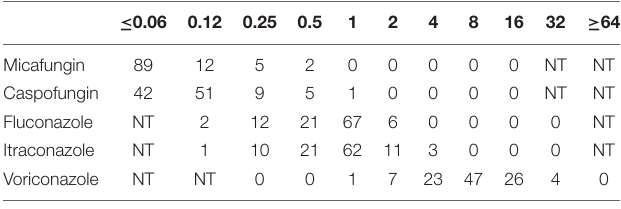
TABLE 1 | The number of strains with MIC50 value of different drugs in 55 planktonic Candida albicans . ≤ 0.06 0.12 0.25 0.5